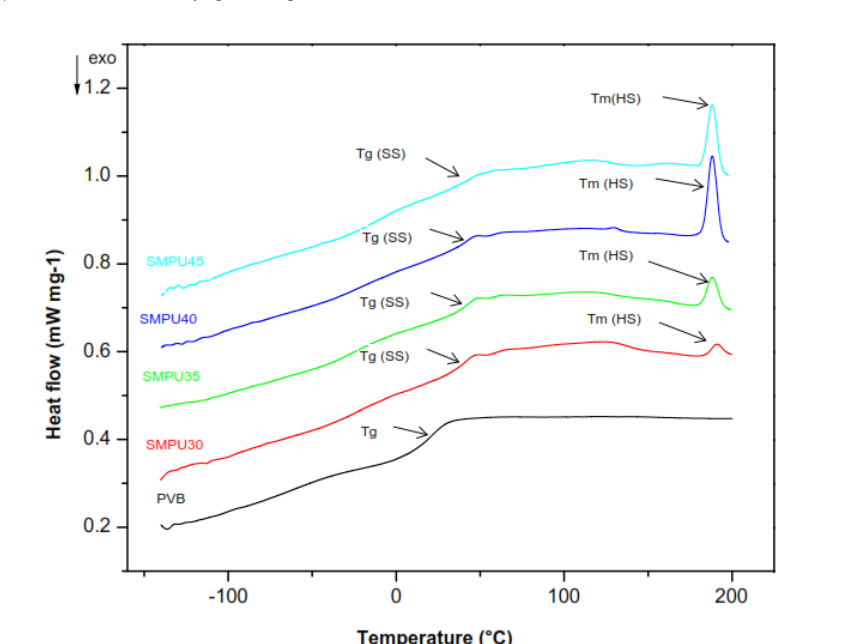
Figure 1. FTIR spectra of SMPUs with varying hard segment content.